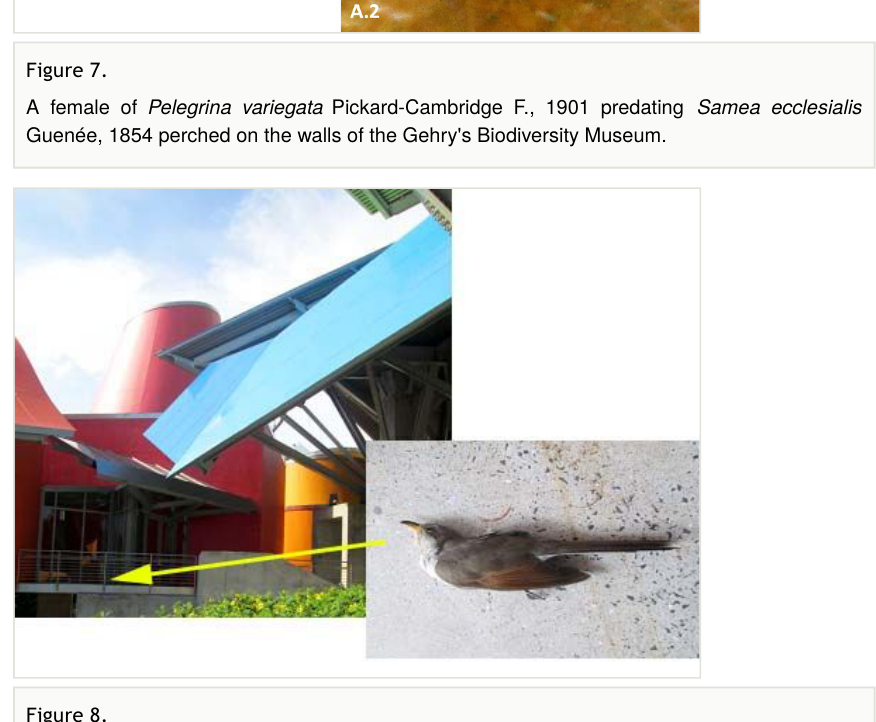
Some birds hit the glass of the Gehry's temporary exhibition corner during their migratory